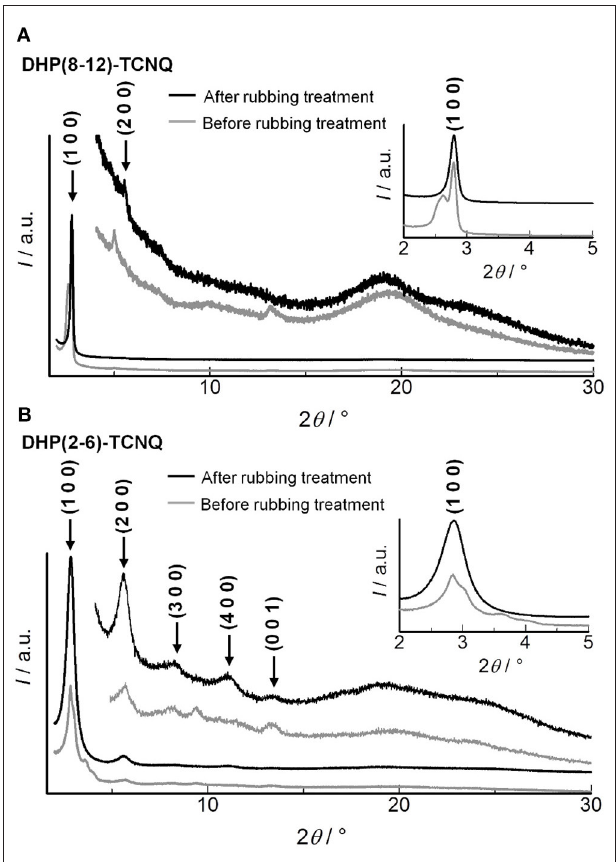
FIGURE 7 | XRD patterns for (A) DHP(8-12)-TCNQ and (B) DHP(2-6)-TCNQ before (gray) and after (black) the repeated directionally random rubbing treatment. Peaks after the rubbing treatment are assigned, as shown in black indices. Detailed assignments of the peaks before and after the rubbing are shown in Tables 1 , 2 ,